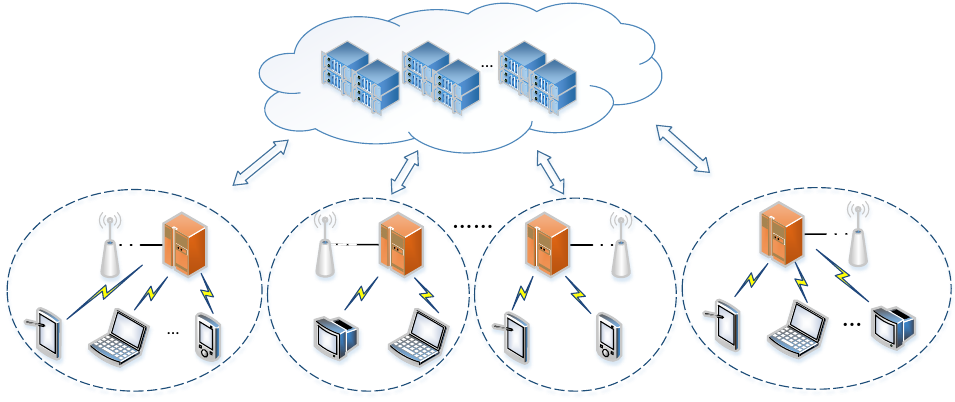
Figure 1. An overview of the system